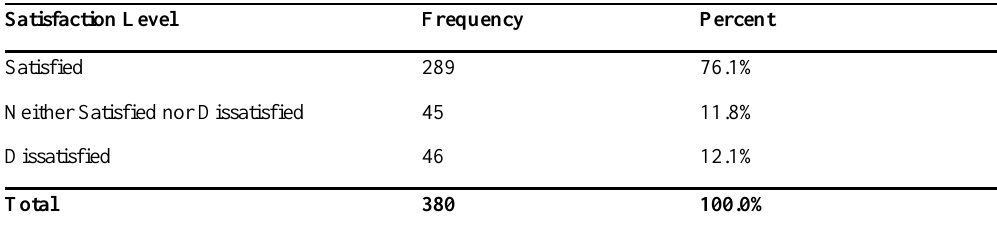
Table 5: Respondents’ Satisfaction with the Cash Transfer